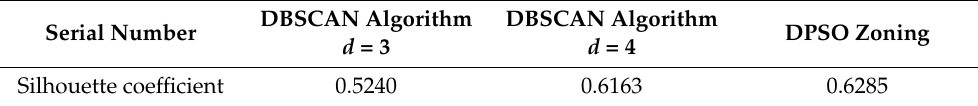
Table 2. Comparison of silhouette coefficient based on DBSCAN and DPSO algorithm.